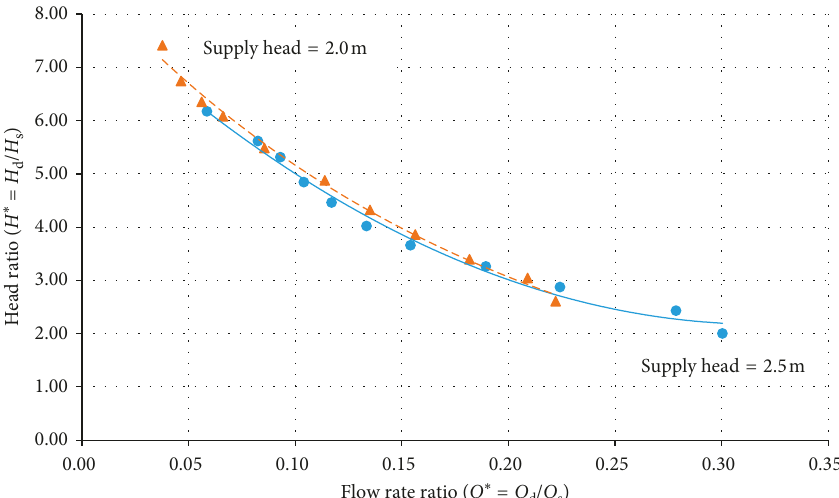
Figure 5: Head ratio vs. flow-rate ratio at difference head, h